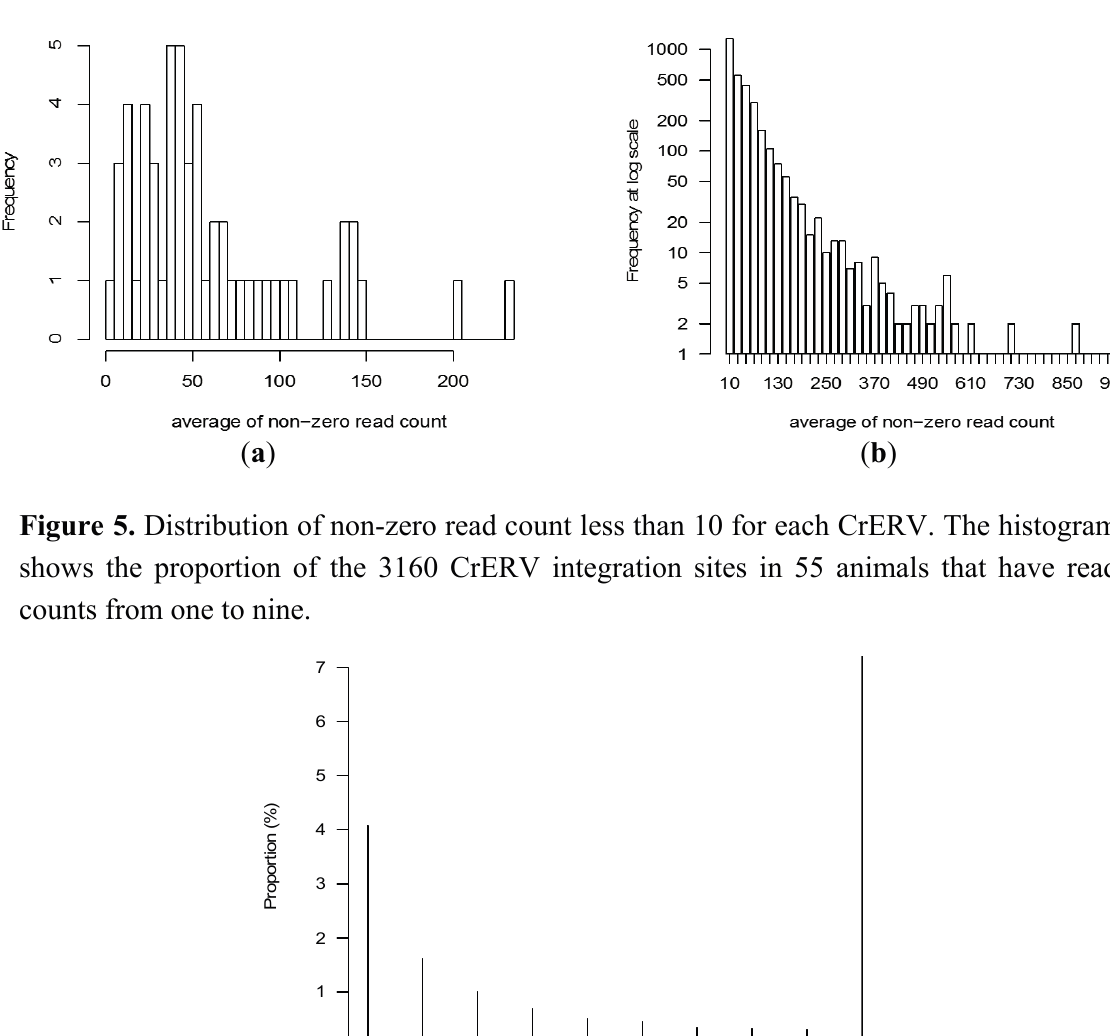
Figure 4. Distribution of reads assigned to CrERV. ( a ) The frequency distribution of the average number of sequences assigned to CrERVs assigned to each of the 55 animals, which includes 10 replicate animals. Variation in read count can occur because of differences in sample preparation, pooling, and between individual sequencing runs. The data show that there is, on average, a read count of 50 for CrERVs from most animals, but two animals have an average of over 200 reads per CrERV; ( b ) The frequency distribution of non-zero read count for the 3160 CrERV. The majority of CrERV integration sites are represented by a read count of between 1 and 100 but four CrERVs have over 850 reads.